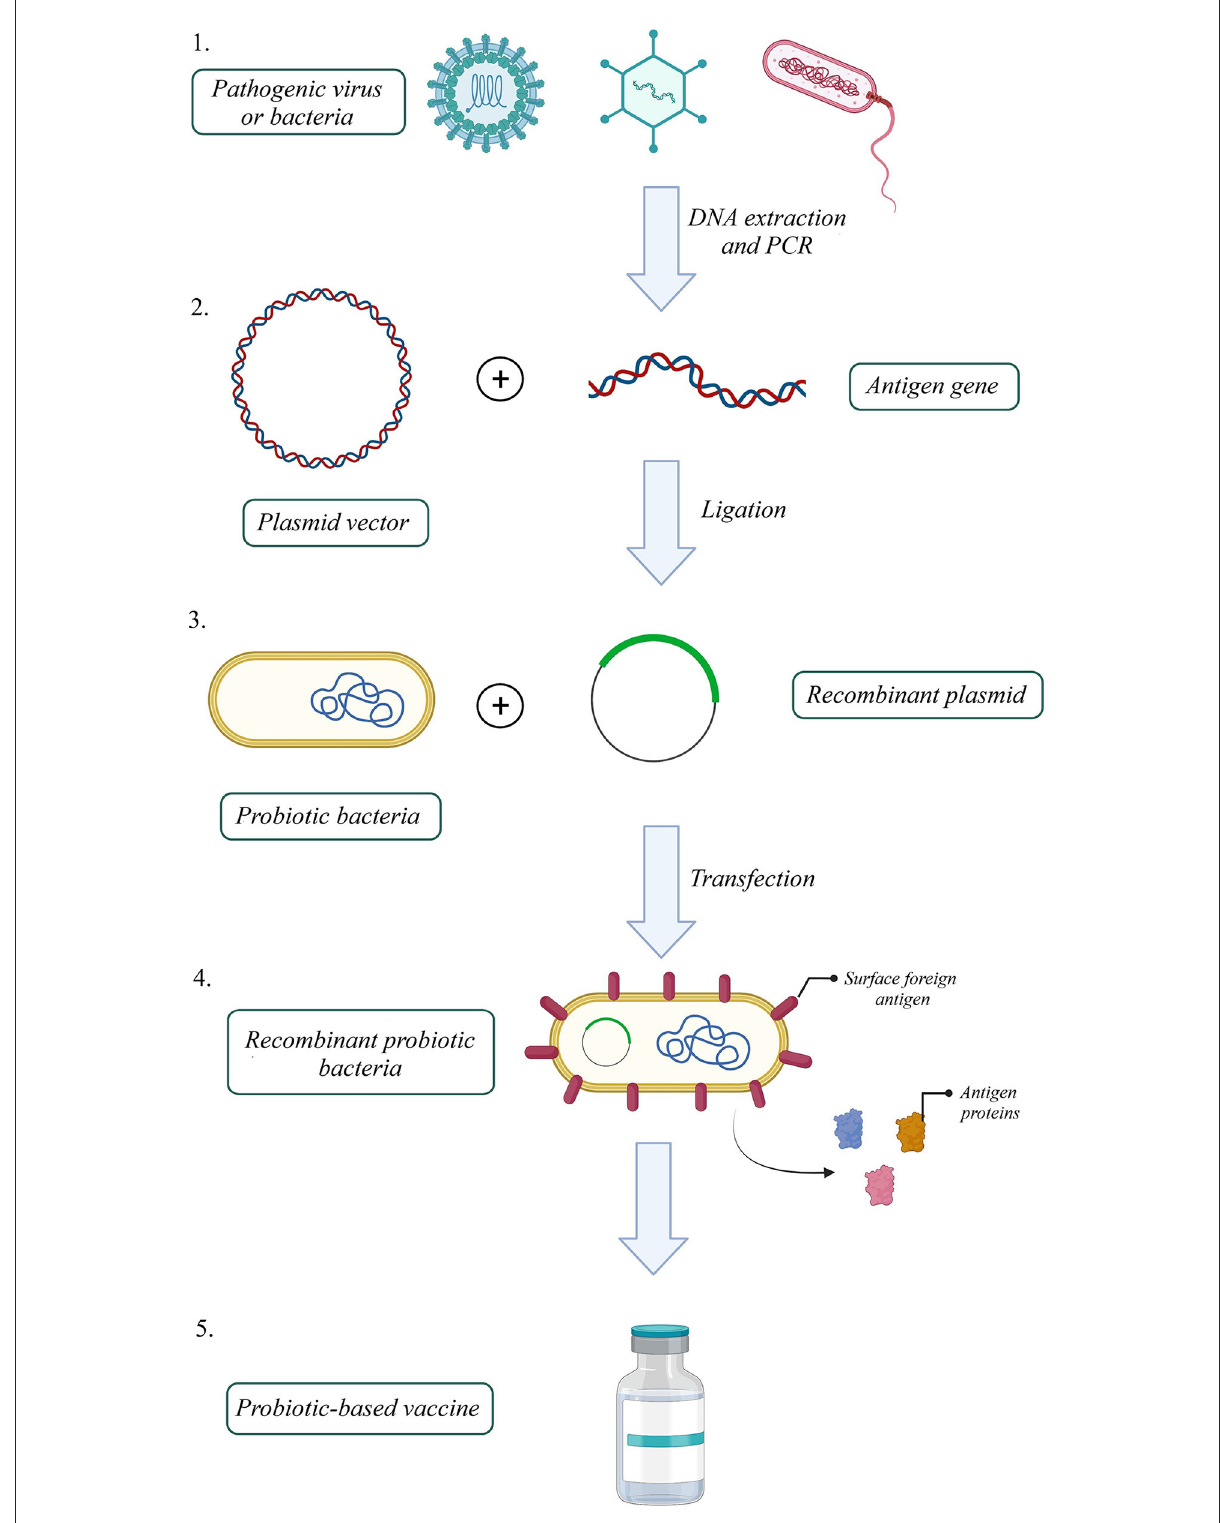
FIGURE1 How to build a probiotic-based vaccine: 1. Extract the antigen gene from the pathogen, 2. Amplify the gene by polymerase chain reaction (PCR), 3. Build a recombinant expression plasmid by ligating antigen gene into a proper plasmid, 4. Transfect recombinant plasmid into a